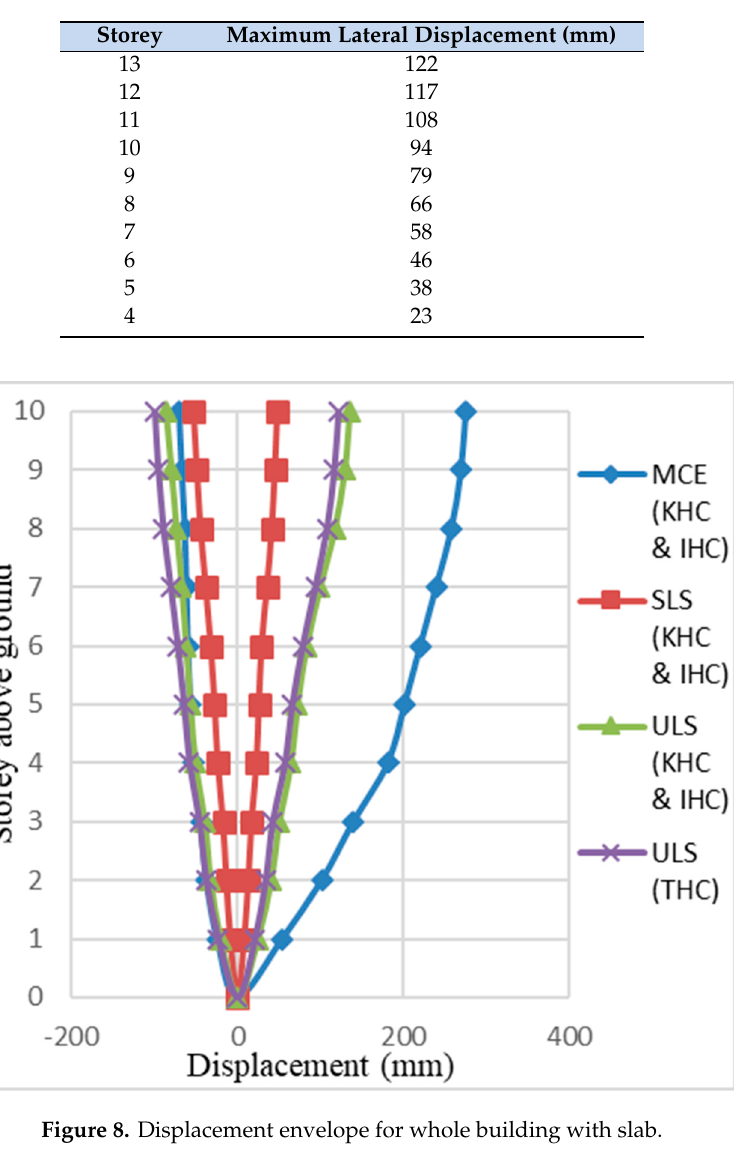
Table 4. Maximum lateral displacement for whole building with slab model including the THC for the ULS case.